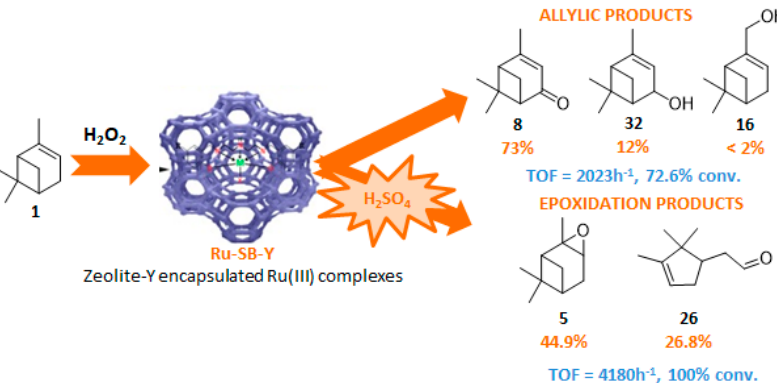
Figure 10. Oxidation of α -pinene with zeolite-Y encaged Ru(III) complex. Influence of H 2 SO 4 (adapted from reference [64]).